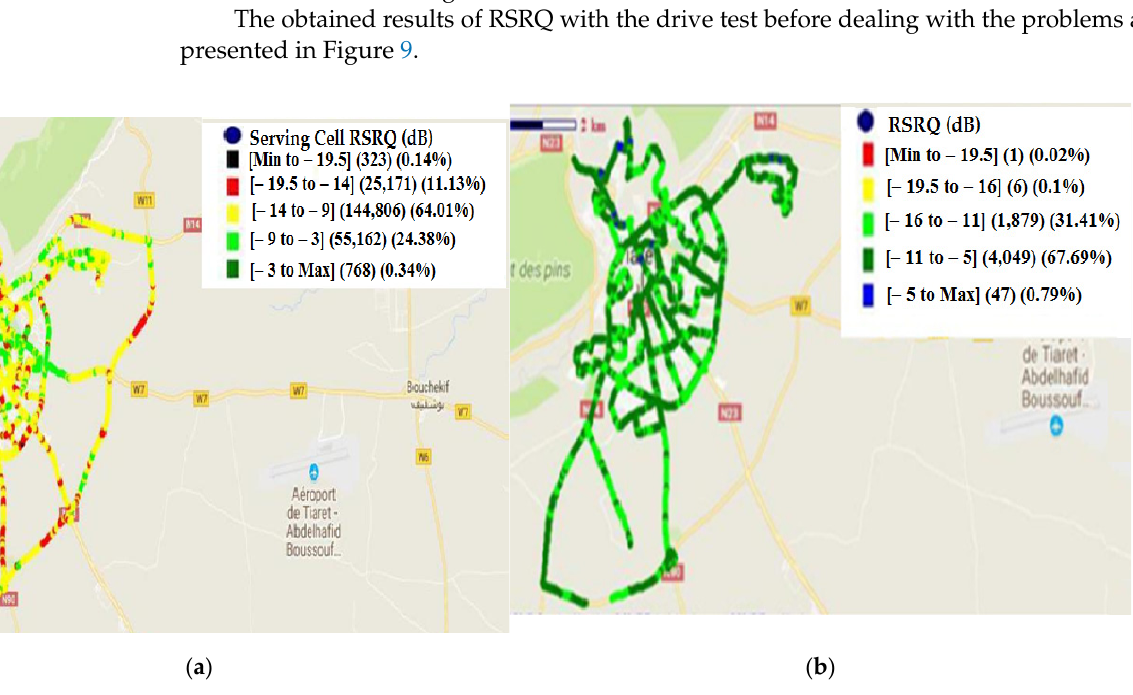
Figure 9. RSRQ distribution: ( a ) before treatment; ( b ) after